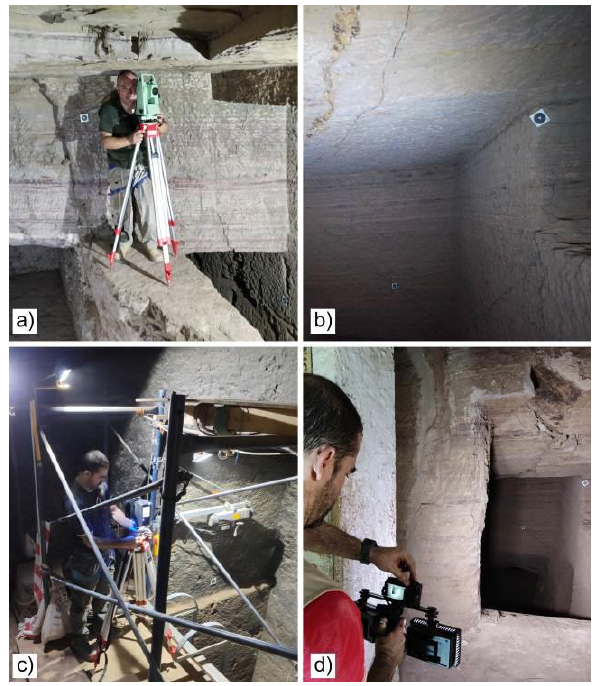
Figure 4. Examples of acquisition stages: a) surveying network using a total station; b) Detail of artificial targets; c) Scanning the QH33 vertical shaft; d) capture of photographs. Figure 3. The first stage included the implementation